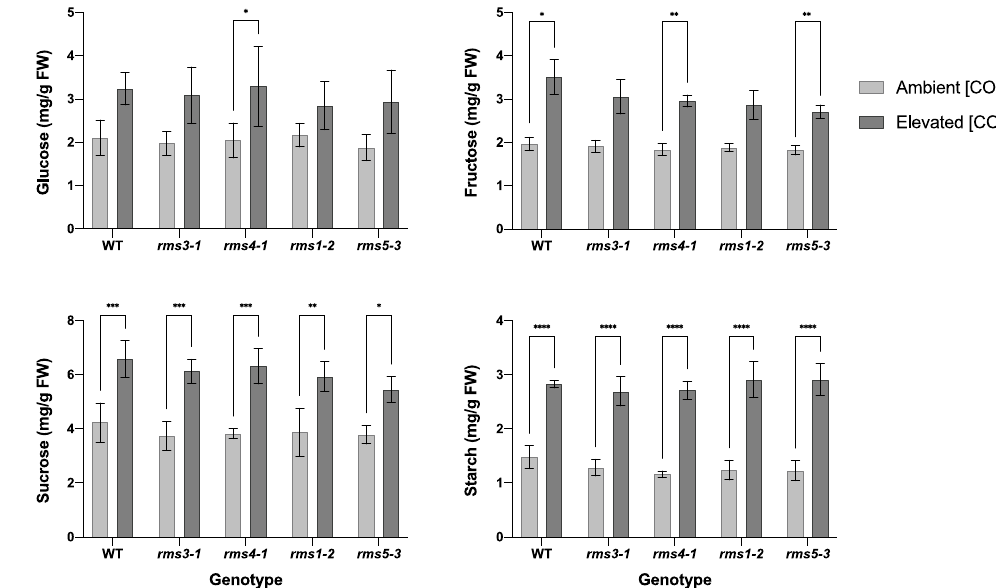
Figure 4. The effect of high CO 2 on the levels of glucose, fructose, sucrose and starch in wild type peas and mutants defective either in strigolactone (SL) synthesis ( rms1 - 2 and rms5-3 ) or signaling ( rms3 - 1 and rms4-1 ). Plants were grown for 28 days either under ambient (420 ppm CO 2 ; bottom row) or high (750 ppm CO 2 ; top row). Data shown as mean ± SD of three replicates. Significant differences between [CO 2 ] within genotype are indicated as: * p <0.05; ** p < 0.01; *** p < 0.001; **** p <